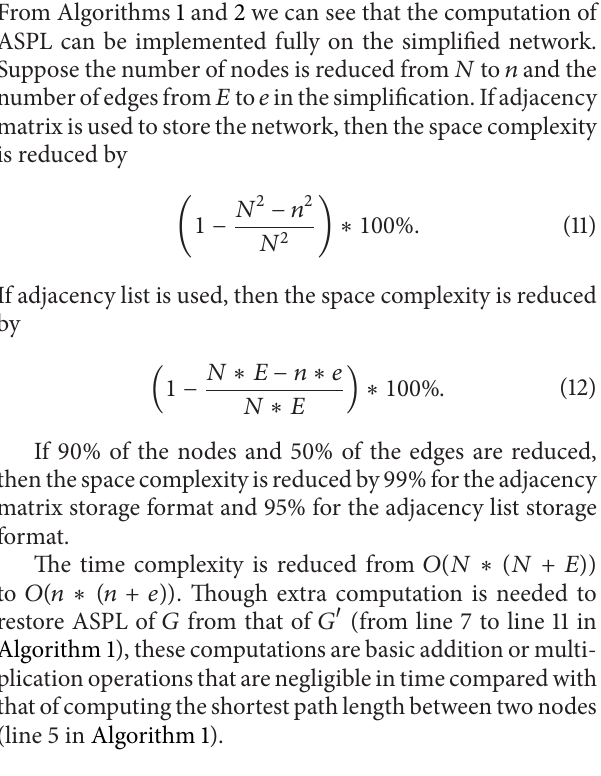
connectors refer to those connectors that cannot be simplified again. For the network listed in Figure 1, the adjacency list is from the connectors in the lowest level, which are node